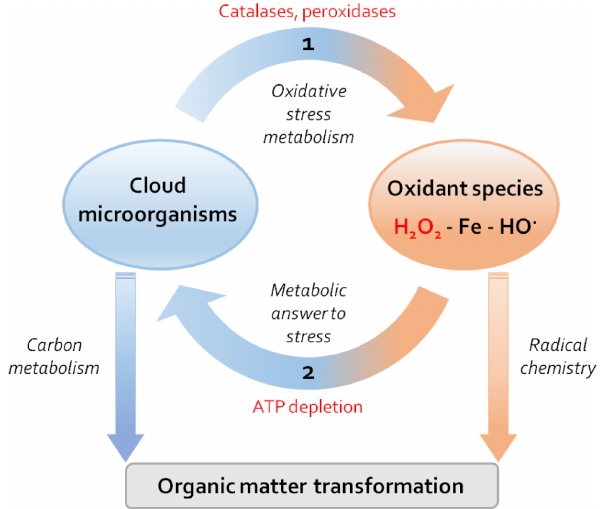
Figure 6. Interaction between H 2 O 2 and cloud microorganisms and its potential consequences for atmospheric chemistry. (1) Cloud mi- croorganisms degrade H 2 O 2 thanks to their catalases and perox- idases (oxidative stress metabolism); as a result, this impacts the oxidant capacity of clouds. The concentration of radicals issued from H 2 O 2 is decreased and radical chemistry is less efficient at transforming the organic matter. (2) H 2 O 2 impacts the energetic metabolism of microorganisms that react to this stress. The deple- tion of ATP modulates the global carbon metabolism of the mi- croorganisms, and consequently the transformation of the organic matter. These processes are modulated by the H 2 O 2 concentration that varies depending on the atmospheric